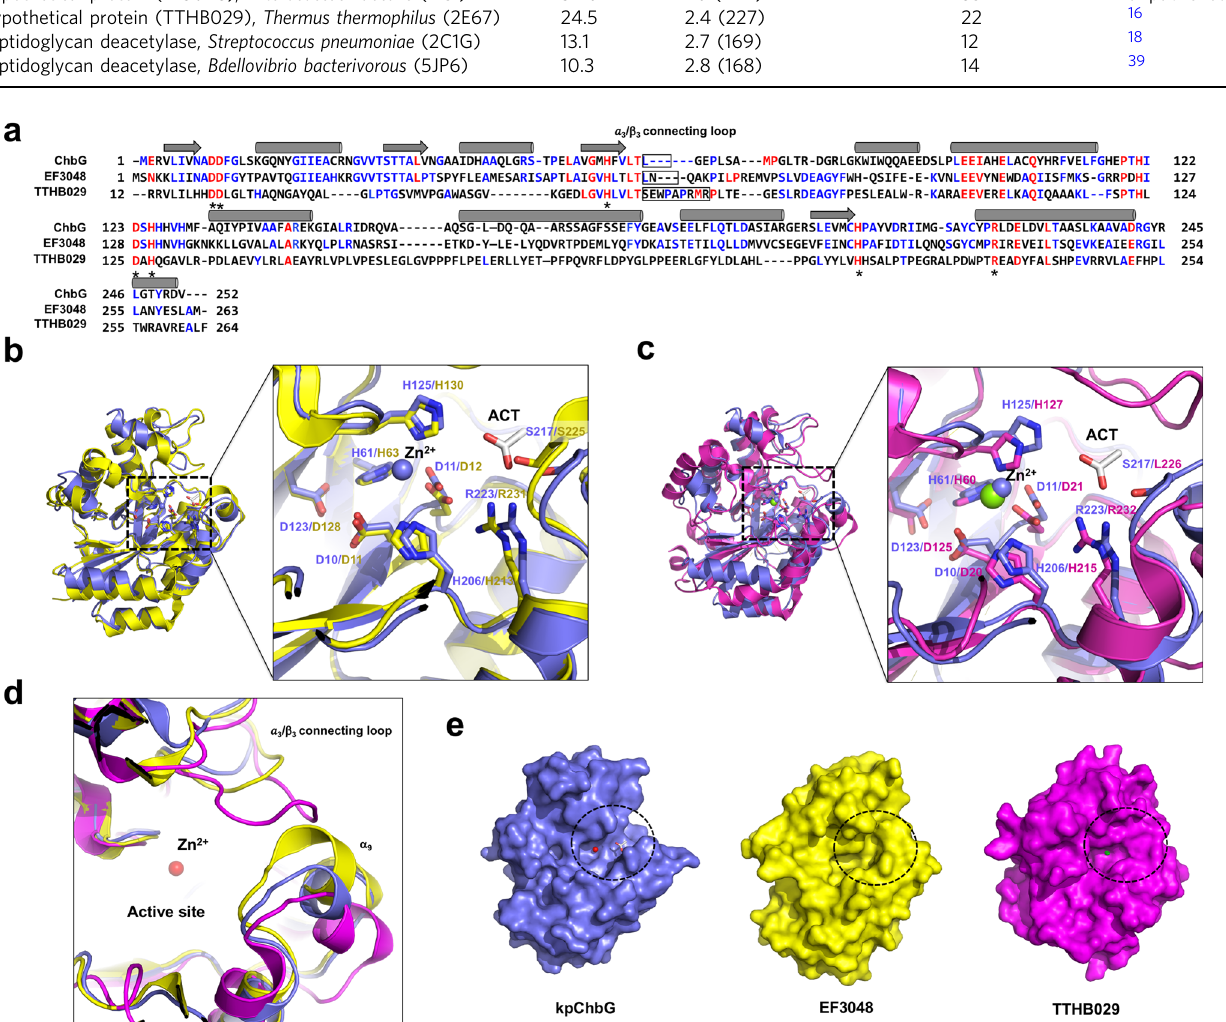
Fig. 4 Comparison of kpChbG with its structural homologs: hypothetical proteins EF3048 and TTHB029. a Sequence alignment using Clustal Omega. Completely conserved and partially conserved residues are colored red and blue, respectively. The positions of the α 3/ β 3 connecting loop and the α 9 helix are indicated by black squares. Conserved residues that are involved in the formation of the putative active site are indicated by asterisks (*). Structural superposition of kpChbG (light blue) with EF3048 (yellow) ( b ) and TTHB029 (magenta) ( c ). Black-dashed boxes indicate the magni fi ed region of the putative active site. d Cartoon representation showing the speci fi c region containing the α 3/ β 3 connecting loop and the α 9 helix around the putative active site which might be critical for substrate speci fi city. kpChbG (light blue color), EF3048 (yellow color), and TTHB029 (magenta color) were superposed for structural comparison. e Overall surface feature of the three homologous proteins. The black-dashed circle indicates the ChbG active site containing the α 3/ β 3 connecting loop and the α 9 helix.